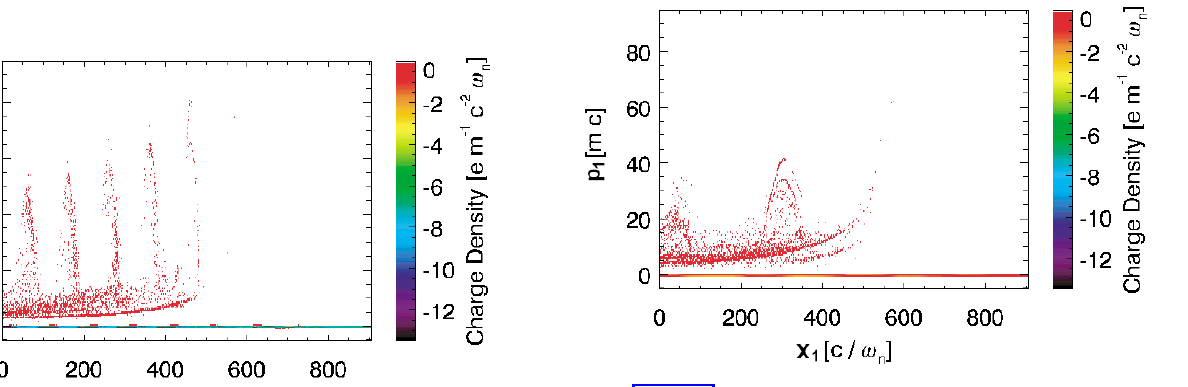
FIG. 6. (Video) The longitudinal phase space density plot at the time when the laser has reached the end of the constant den- sity region of the second gas jet, which has a much lower density than the first gas jet. The parameters for the first gas jet in this simulation are w 1 (cid:1) 1.5 mm, L g 1 (cid:1) 0.5 mm, and n p 1 (cid:1) 7.07 3 10 18 cm 2 3 . The parameters for the second gas jet are w 2 (cid:1) 1.5 mm, L g 2 (cid:1) 0.5 mm, and n p 2 (cid:1) 1.0 3 10 18 cm 2 3 . The distance between the gas jets is d (cid:1) 65 m m. See video 2 for the dynamic development of the phase